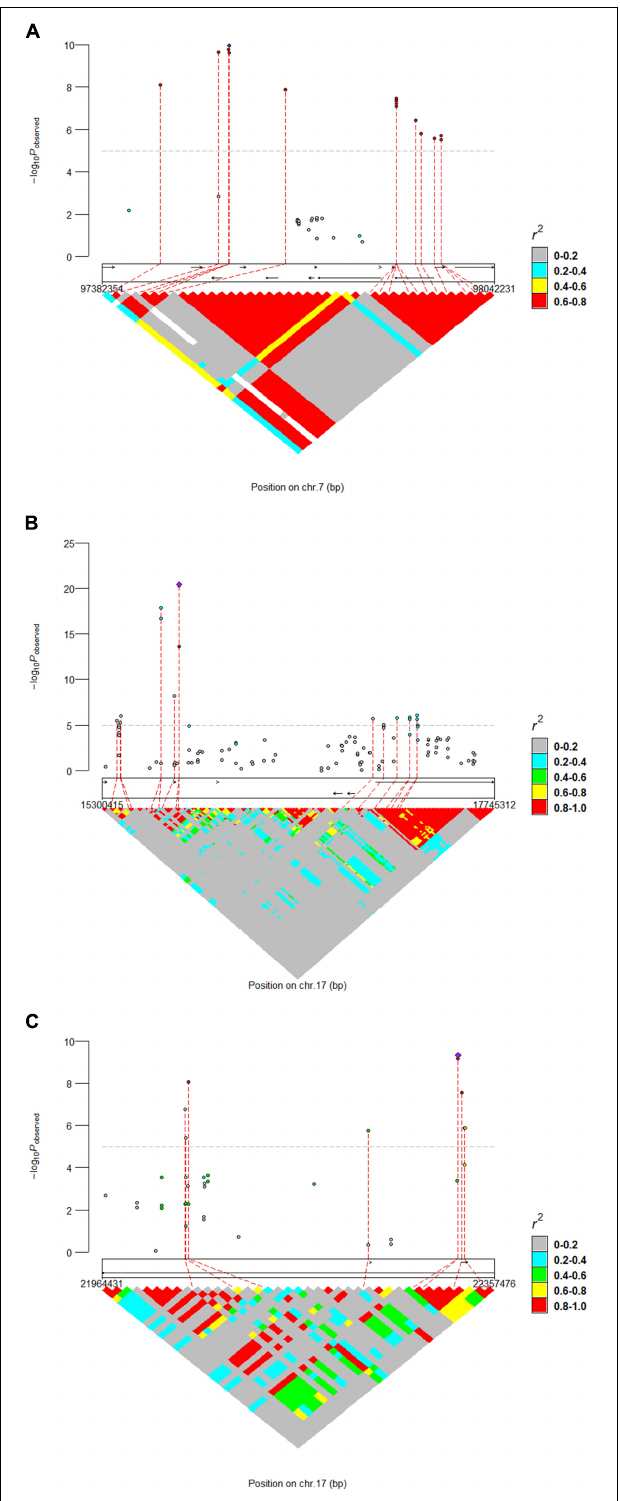
FIGURE 3 | Locus-specific Manhattan plot and linkage disequilibrium analysis for (A) total teat number and (B,C) body length. The horizontal dashed line indicates the significance thresholds ( P -value = 1.41E-5). The most significant SNP within each region was annotated with corresponding candidate